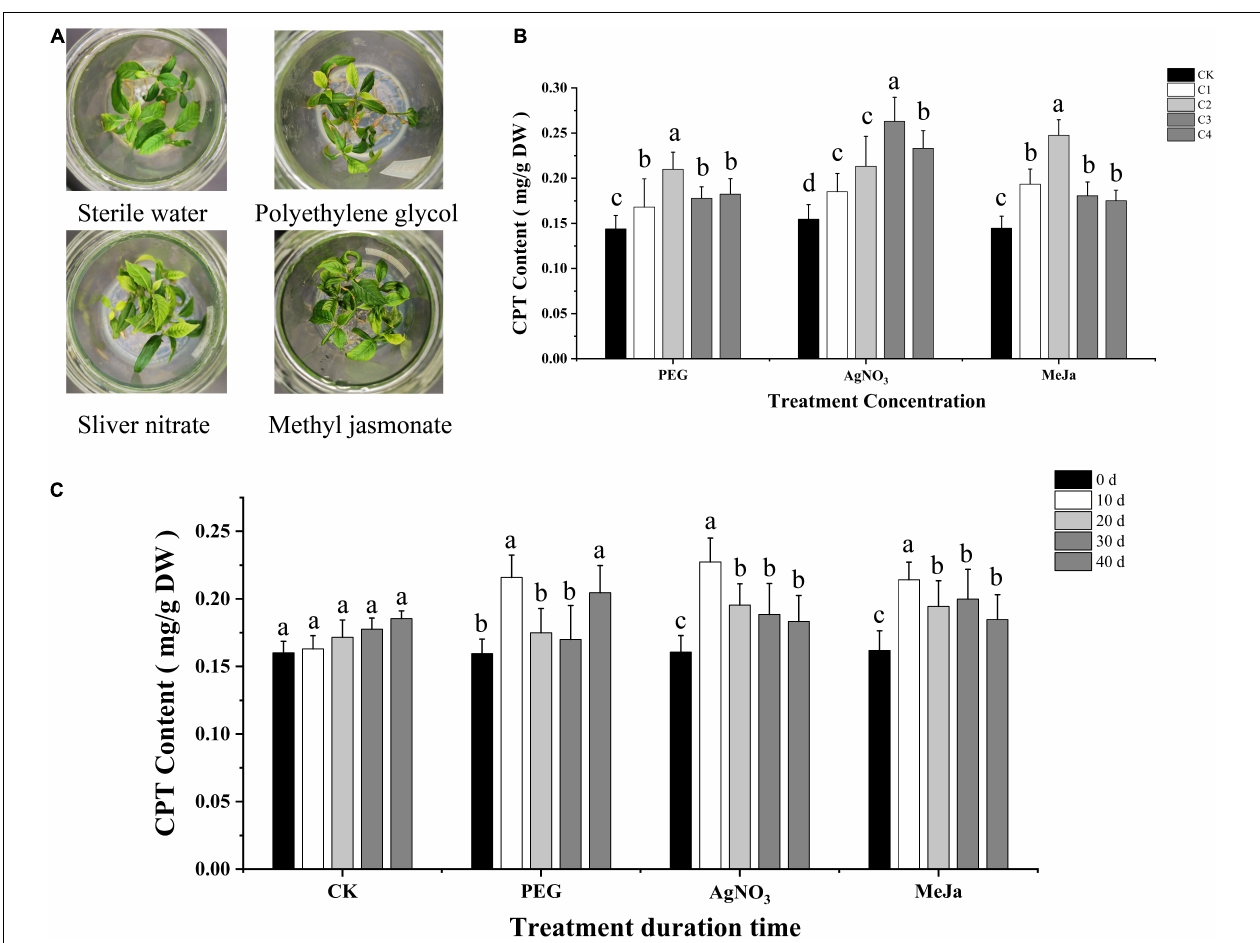
FIGURE 2 | Optimization of elicitation conditions. (A) C. acuminata plantlets after elicitation treatments with PEG, AgNO 3 , and MeJa. (B) CPT contents (mg/g) under different treatment concentrations (C1–C4). (C) CPT contents (mg/g) at different treatment durations (0–40 days). Different letters (a, b, c, d) indicate significant differences at P < 0.05 ( t -test). MeJa, methyl jasmonate; AgNO 3 , silver nitrate; PEG, polyethylene glycol-20000; CK, control group.